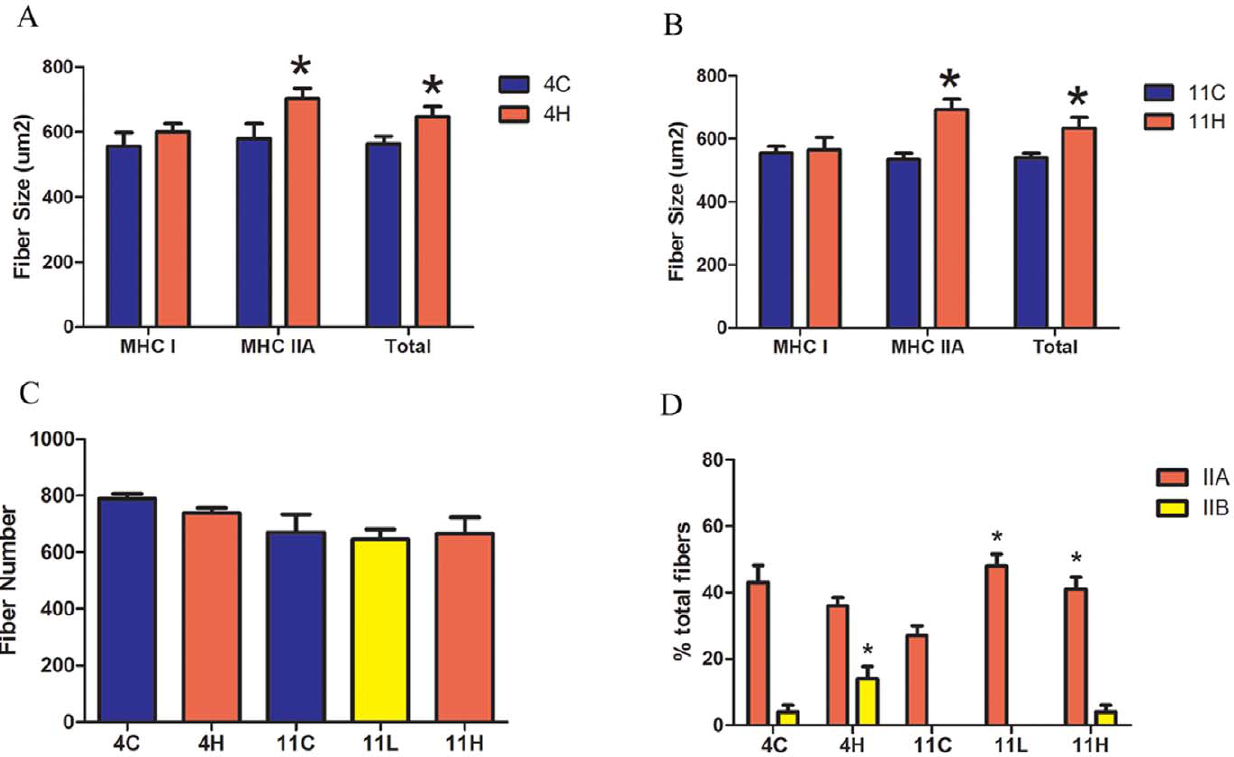
Figure 6. Morphological analysis of the mdx soleus. At the four month (a) and eleven month (b) timepoint myostatin inhibition did not change the mean fiber size of type I fibers but did increase the mean fiber size of myosin heavy chain (MHC) type IIA and total fibers. (c) Overexpression of dnMstat did not change the number of fibers in the midbelly cross section of the soleus. (d) In the mdx 4H group, the percentage of type IIB fibers was increased from 4% to 14%. At eleven months of age there is no significant difference in the percentage of IIB fibers among the experimental groups. However the mdx 11L and mdx 11H soleus contained 20–21% more type IIA fibers. Data represent mean 6 SD. * Statistically significant compared to control, p ,